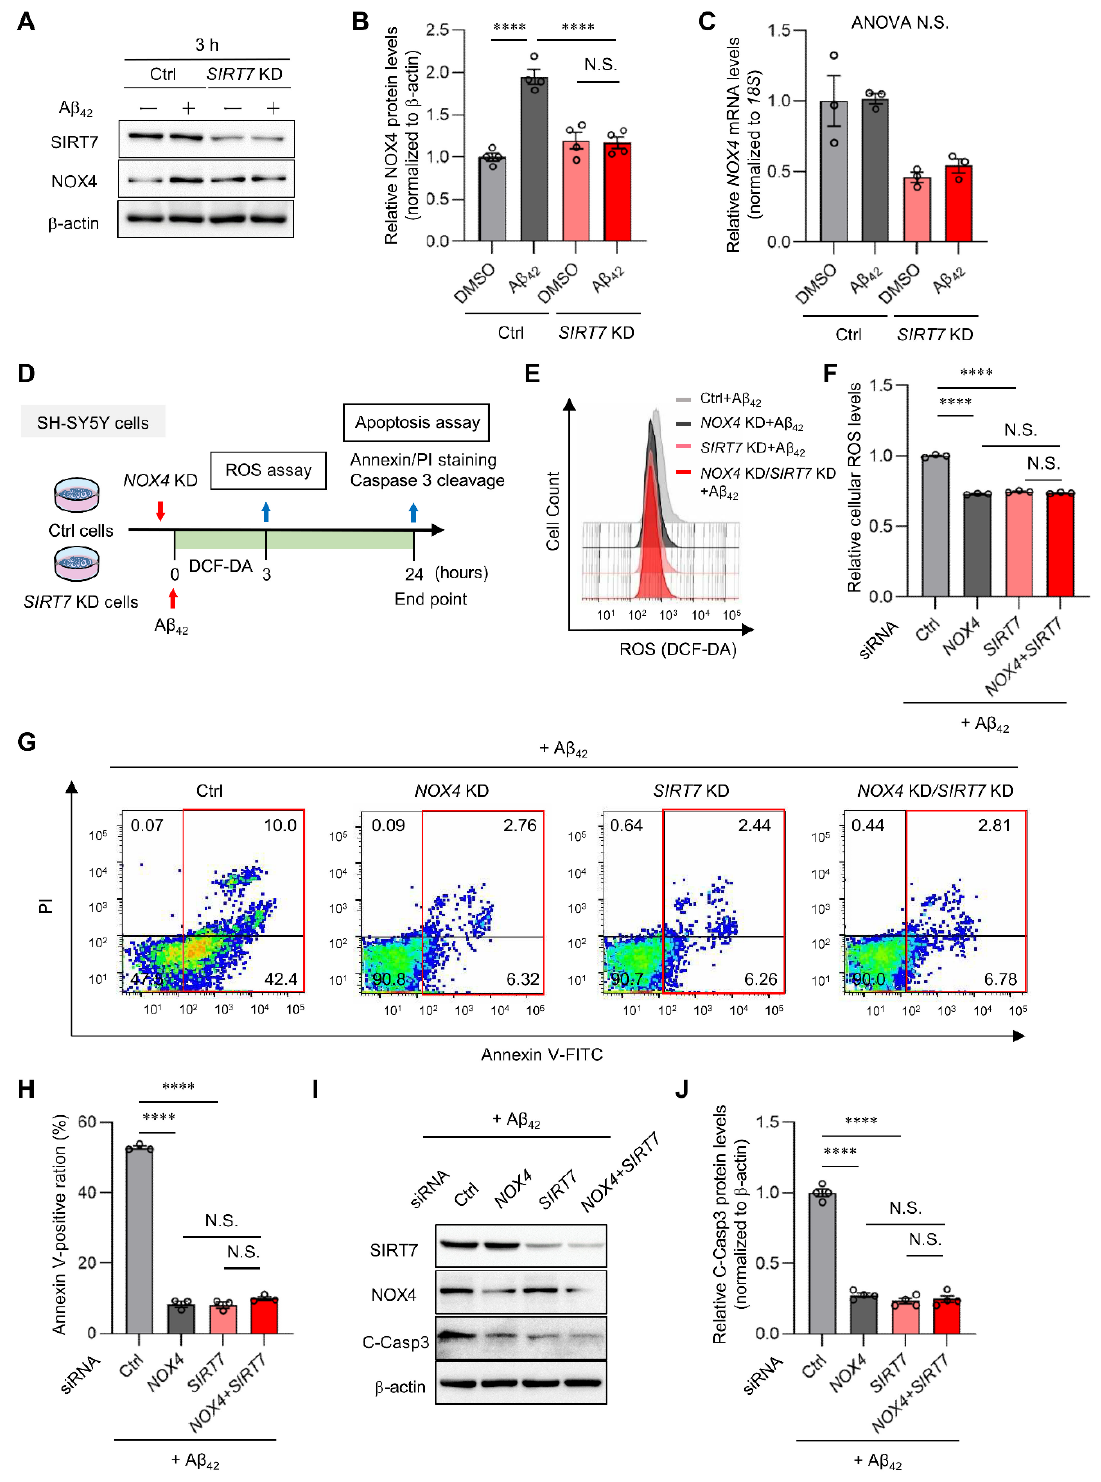
Figure 5. SIRT7 deficiency inhibits Aβ -induced NOX4 protein expression. ( A ) Western blot analysis of NOX4 was performed when control and SIRT7 KD SH-SY5Y cells had been treated with Aβ 42 for 3 h. ( B ) The value of NOX4 was normalized to that of β -actin. ( C ) NOX4 mRNA expression was determined with the quantitative real-time RT-PCR analysis of cells treated in the same condition as that in Figure 5A. The value of NOX4 mRNA was normalized to that of 18S rRNA . ( D ) Experimental scheme for the effect of double KD of SIRT7 and NOX4 on Aβ 42 -induced ROS and apoptosis. ( E ) Control and NOX4 KD SH-SY5Y cells transfected with either control siRNA or SIRT7 siRNA were treated in the presence of 5 μM Aβ 42 for 3 h. Intracellular ROS levels were evaluated by flow